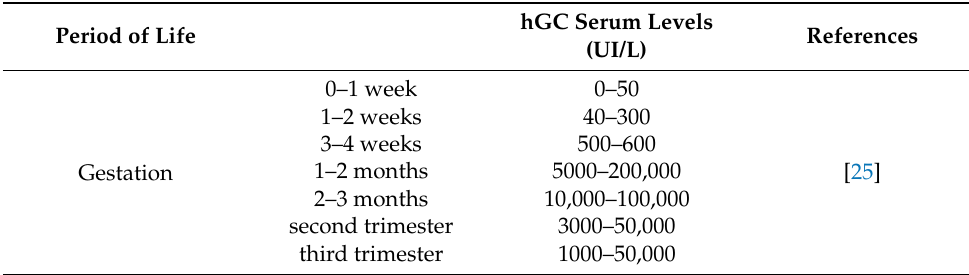
Table 1. Serum hCG levels during